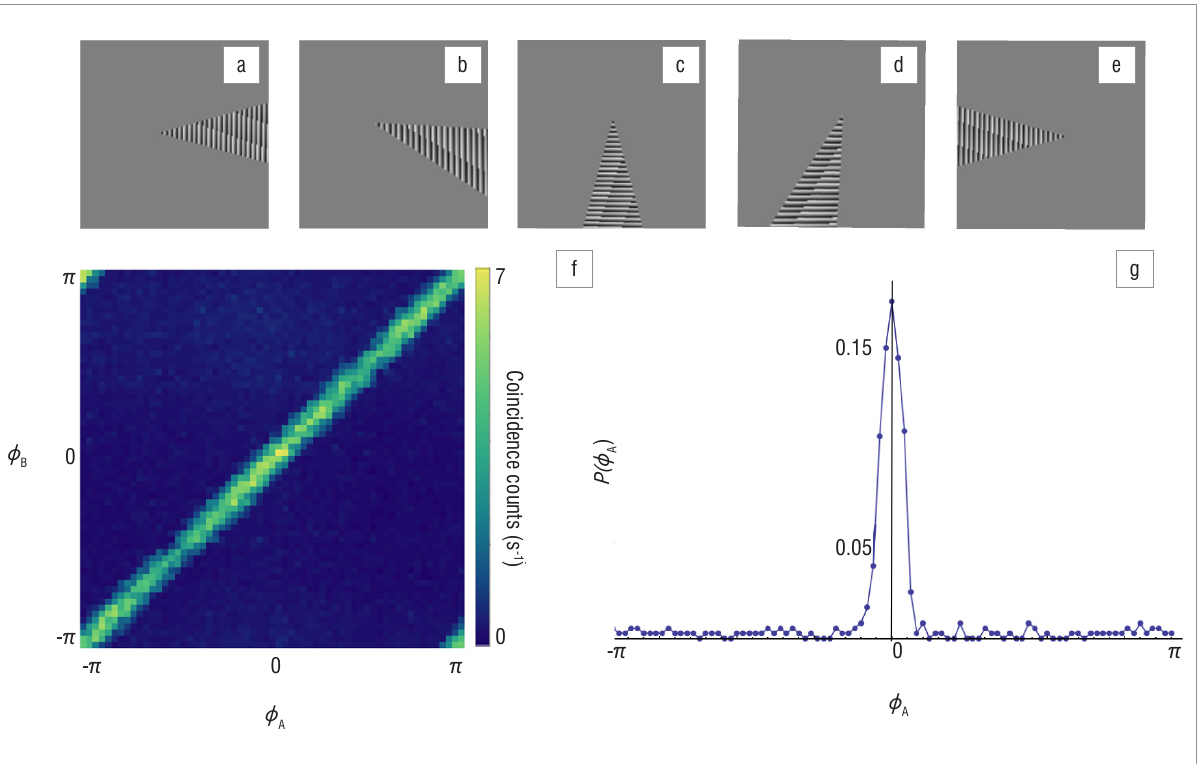
Figure 6: Experimental measurements of the angular position. (a–e) The holograms on each spatial light modulator were rotated through 2π, where the angular width of the ‘slice’ was set at Δ ϕ =15°. Experimental measurements showing (f) a density plot of the coincidence counts per second using the angular holograms and (g) a probability distribution of the angular position ϕ